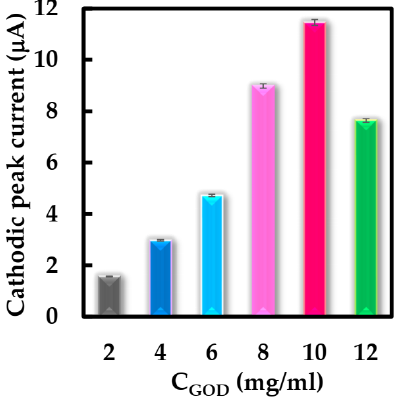
Figure 6. ( A ) CVs of NF-GLA/MWCNTs-BSA-HFs-GOD/GCE electrode in N 2 -saturated 50 mM phosphate-buffered solution at different pH values (from left to right): 4.0, 5.0, 6.0, 7.0, 8.0, and 9.0, respectively, at a scan rate of 0.05 V · s − 1 . ( B ) Plot of cathodic peak current versus pH value. ( C ) Plot of E ◦(cid:48) versus pH value.